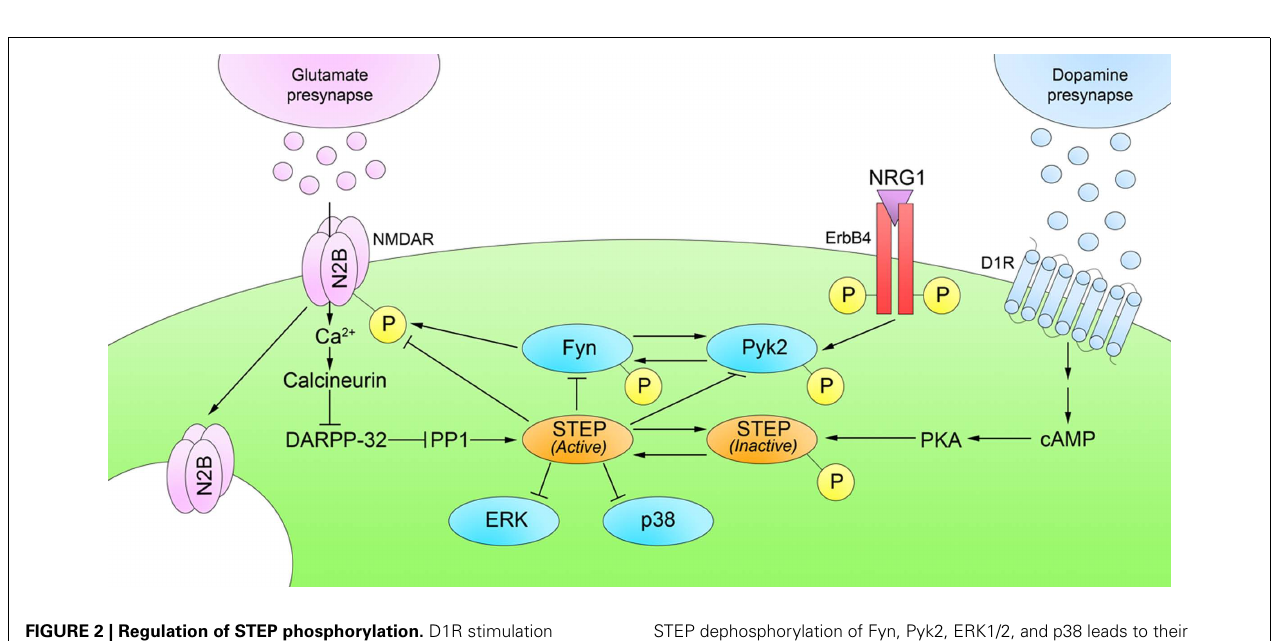
FIGURE 2 | Regulation of STEP phosphorylation. D1R stimulation phosphorylates and inactivates STEP through a cAMP/PKA pathway. Glutamatergic stimulation of NMDARs reverses this process by dephosphorylation and activation of STEP through a calcineurin/PP1 pathway. Active STEP dephosphorylates regulatory tyrosines within STEP substrates.